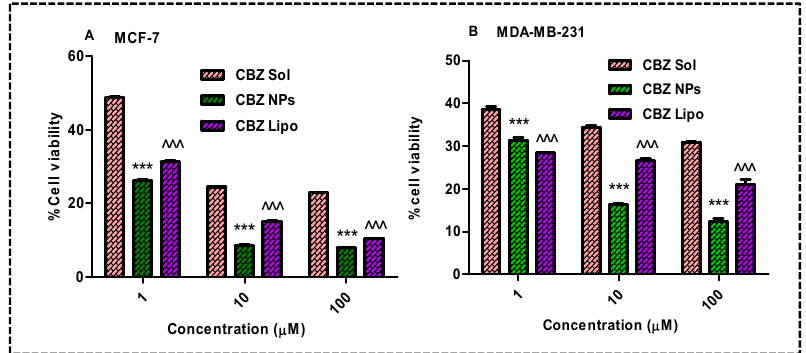
Figure 4. Cell viability assay: MCF-7 and MDA-MB-231 cells were treated with formulations for 48 h and the percentage of cell viability was calculated in comparison with control, ( A ) there was a significant decrease in the percentage of cell viability by an increase in the concentration of CBZ on MCF-7 cells after treatment with CBZ NPs and CBZ liposomes (*** p < 0.001 and ^^^ p < 0.001) in comparison with the CBZ micellar solution, respectively, ( B ) significant reduction in the percentage of cell viability by an increase in the concentration of CBZ on MDA-MB-231 cells after treatment with CBZ NPs and CBZ liposomes (*** p < 0.001 and ^^^ p < 0.001) in comparison with the CBZ solution respectively; the data was represented in mean ± SD.